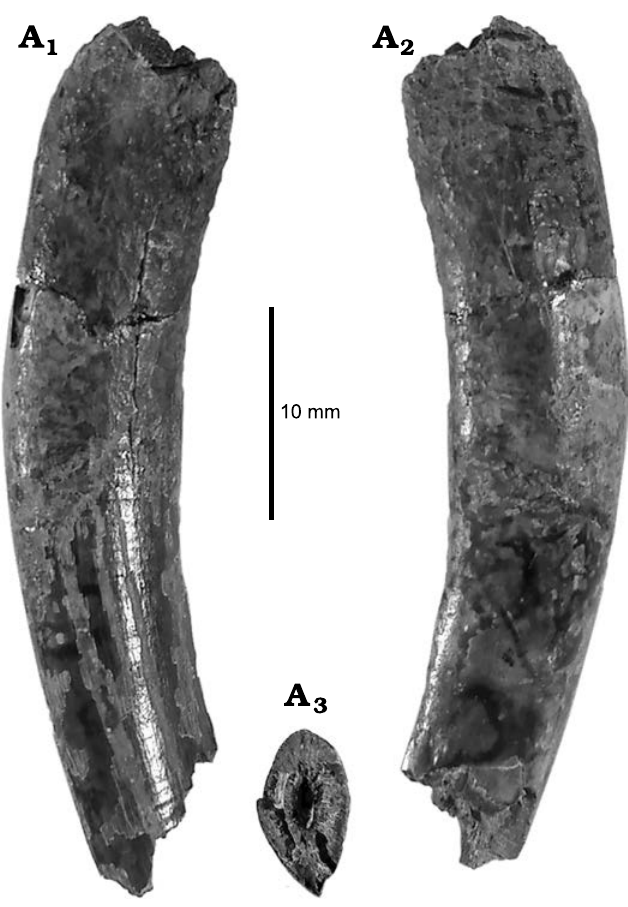
Fig. 4. Palaeomerycid artiodactyl tentatively referred to Barbouromeryx trigonocorneus (Barbour and Schultz, 1934), from locality OMNH V974, Eastgate, Churchill County, Nevada, USA; early Barstovian, middle Miocene. OMNH 77369, partial upper tusk (C1) in labial view with rem- nant strips of very thin enamel (A 1 ), lingual view (A 2 ), cross-section at natural break in crown (A 3